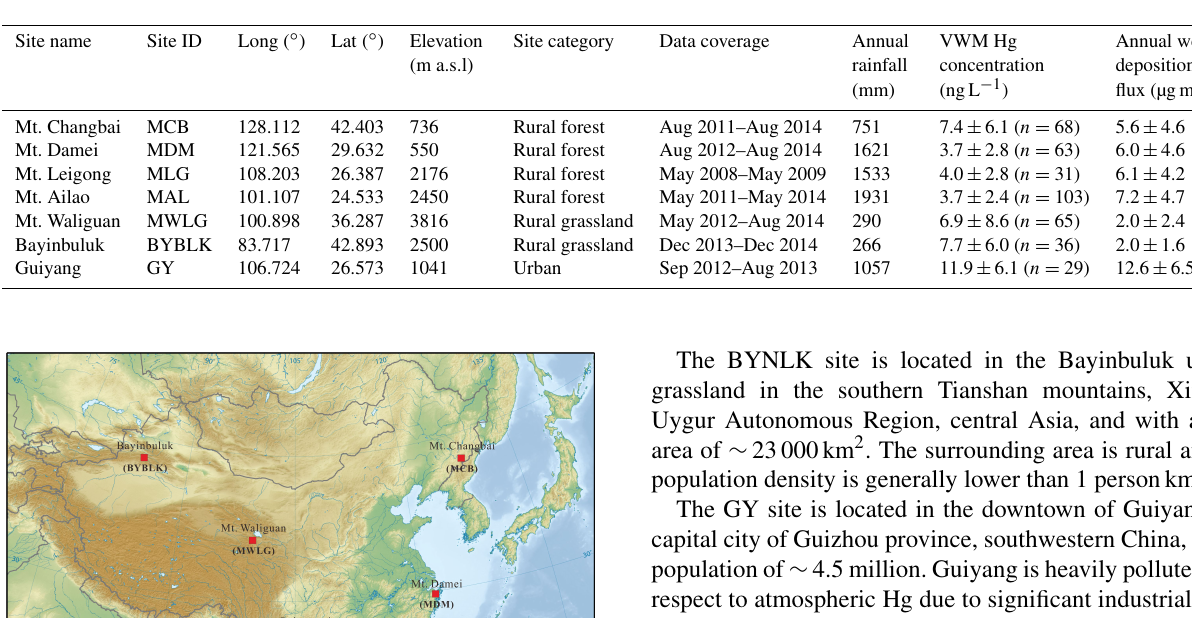
Table 1. Sampling site information, volume-weighted mean (VWM) concentrations and annual wet deposition fluxes of Hg in precipitation at remote sites and an urban site of China.